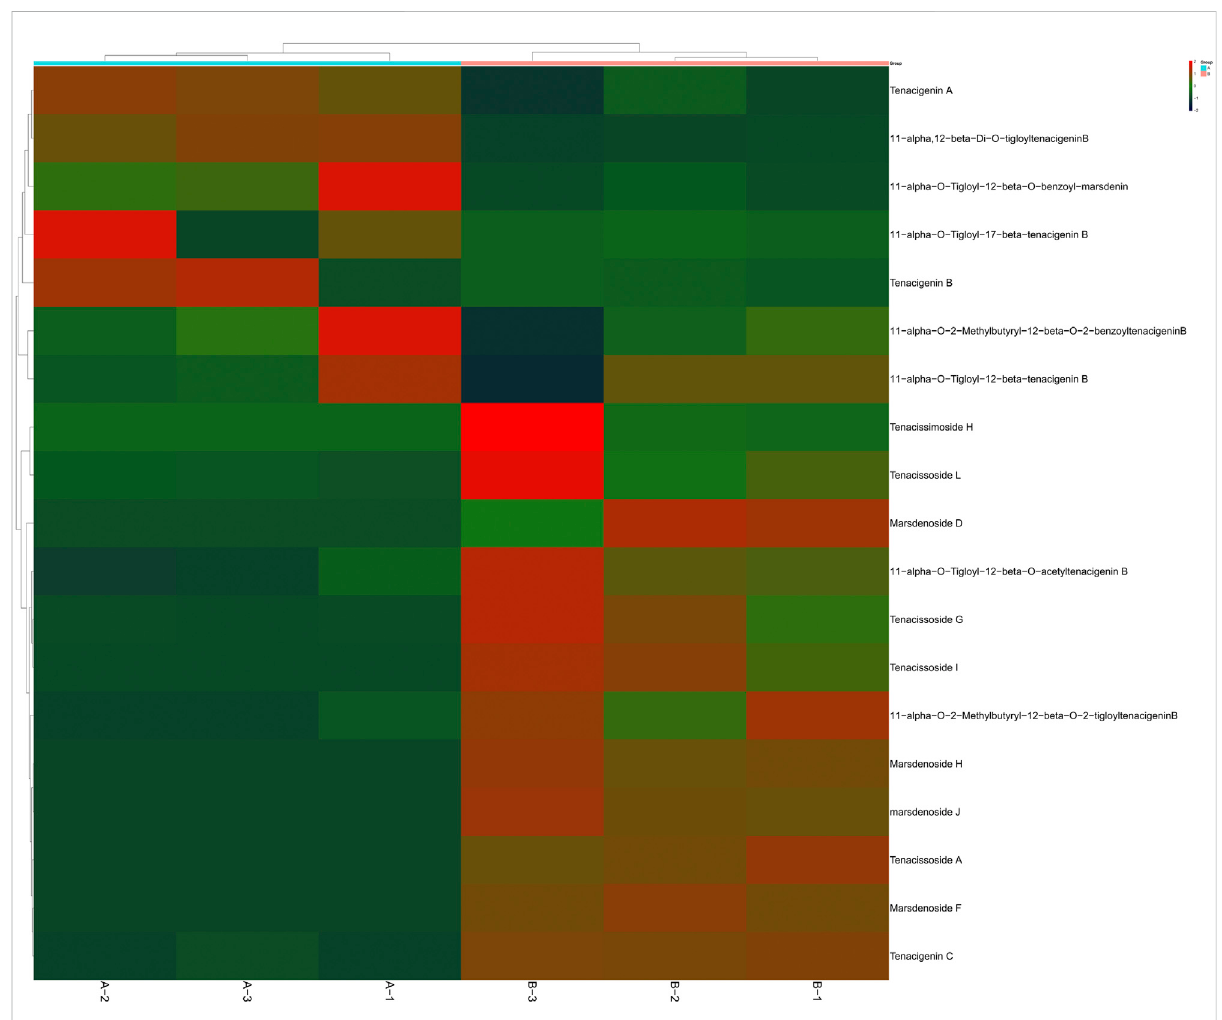
FIGURE 10 Heat-map of C 21 steroidal glycosides in Marsdenia tenacissima (MT) and Marsdenia tenacissima with Ganoderma lucidum co-fermentation (MGF). (A) : MT (B) :